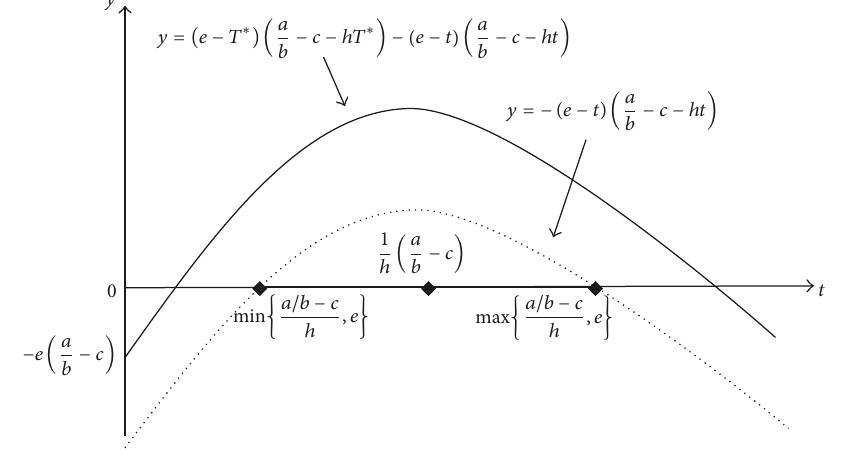
Figure 4: Effect of changes in 𝑐 on 𝑇 ∗